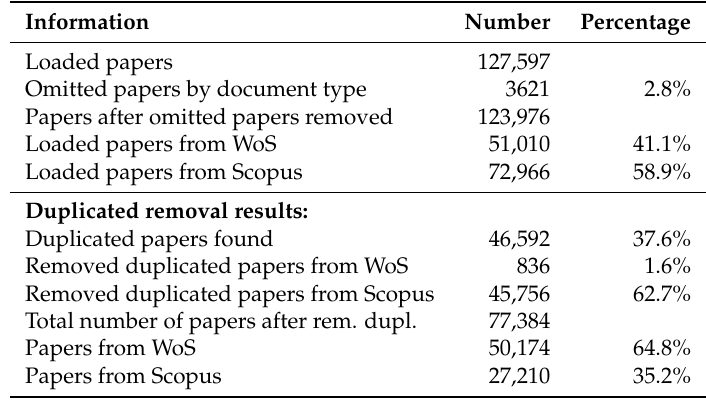
Table 1. FPGA dataset preprocess brief table. Omitted papers by document type , Loaded papers from WoS/Scopus and Duplicated papers found percentage relative to Loaded papers . Removed duplicated papers from WoS/Scopus percentages relative to Loaded papers from WoS/Scopus respectively. Papers from WoS/Scopus percentage relative to Total number of papers after rem.